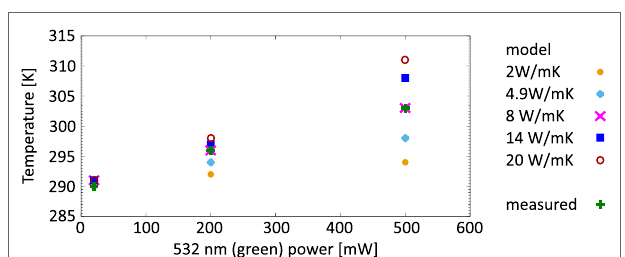
FIGURE 3 | Temperature of the membrane as a function of continuous heating power with the 532nm laser for the same duration as in the experiments. The temperature was obtained from the finite element model for different thermal conductivities of silicon nitride compared to the temperature measured with the thermal camera (green